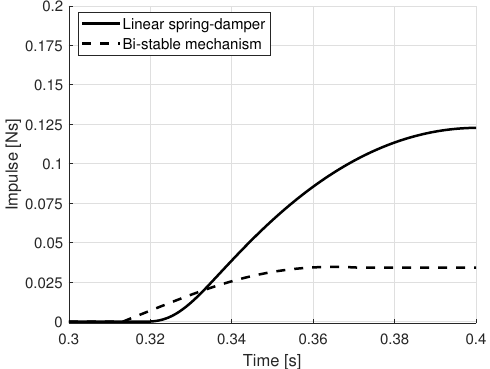
Figure 24. Impulse generated by the decoupling system.